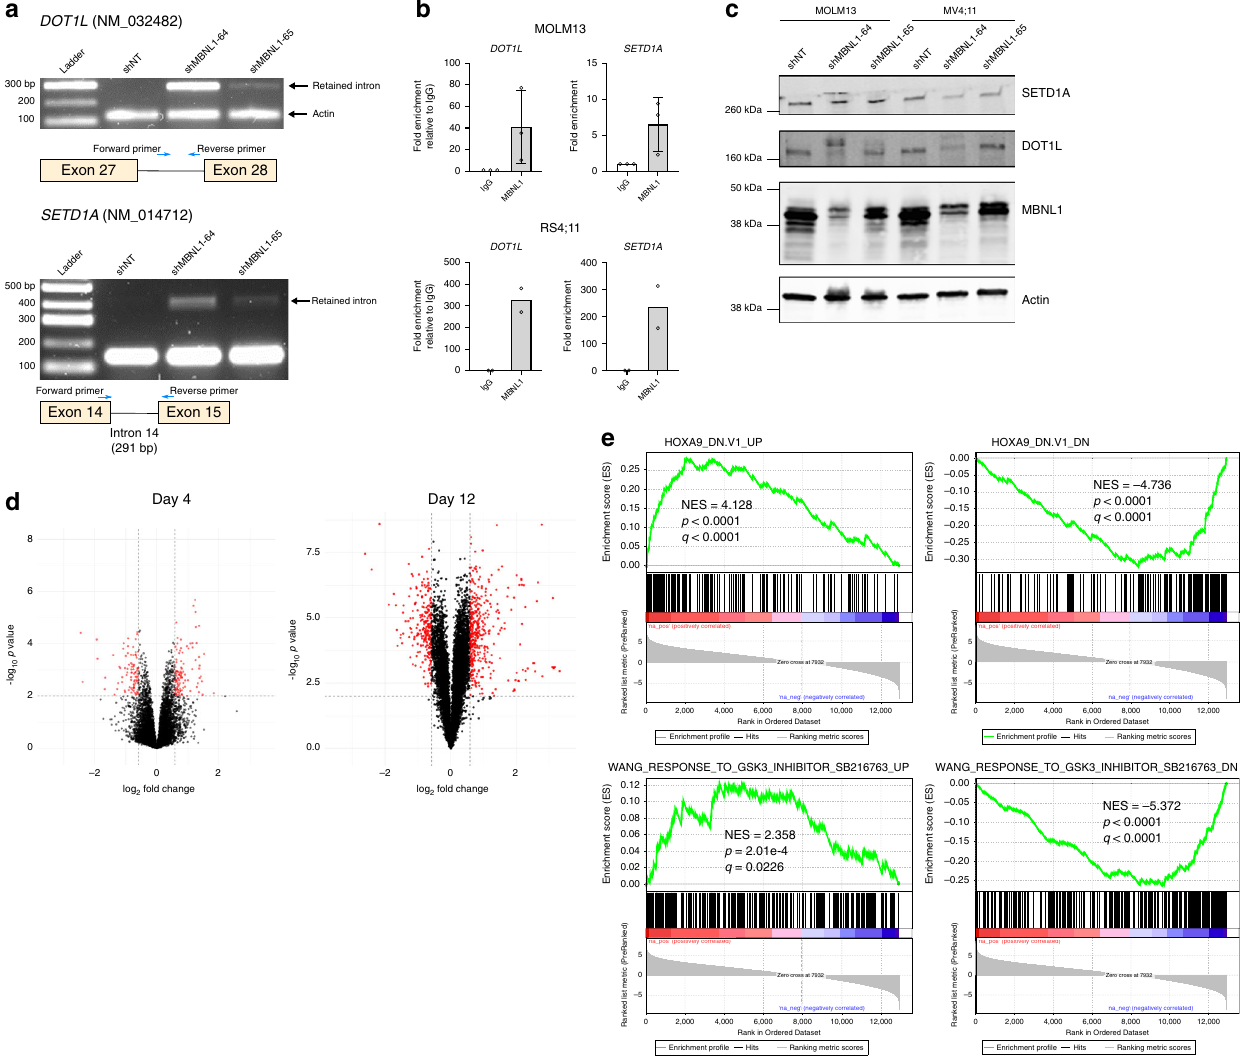
Fig. 7 MBNL1 loss perturbs essential MLL-rearranged leukemia genes through missplicing. a RT-PCR demonstrating the predicted increase in intron retention at alternative splice sites in DOT1L and SETD1A transcripts in MOLM13 cells after MBNL1 knockdown. For DOT1L , Actin serves as a loading control, and primer product ( “ Intron Inclusion Band ” ) only occurs when the intron is retained. Representative gel images shown, two biological replicates performed. b qRT-PCR results from RNA-immunoprecipitation assay assessing for enrichment of DOT1L and SETD1A transcripts in MBNL1-precipitated RNA. Error bars show mean ± SD. Data is from three biological replicates for MOLM-13 and two biological replicates for RS4;11. c Western blots of MOLM13 and MV4;11 cells following knockdown of MBNL1, demonstrating changes in DOT1L and SETD1A protein levels. Representative western blots shown, two biological replicates performed. SETD1A image represents same samples run and processed in parallel on separate blot. d Volcano plots representing differentially expressed genes in MOLM13 cells at 4 days (left) and 12 days (right) after knockdown. X -axis thresholds represent 1.5-fold change in expression; Y -axis threshold represents p < 0.01. Differentially expressed genes determined by empirical Bayes two-tailed moderated t -test. e Differentially expressed genes were signi fi cantly enriched positively and negatively by GSEA for corresponding gene sets related to perturbation of essential MLL leukemogenesis processes (i.e., HOXA9, upper GSEA plots; GSK3, lower plots.) Enrichment scores, p values, and false-discovery rate q values calculated as previously published 51